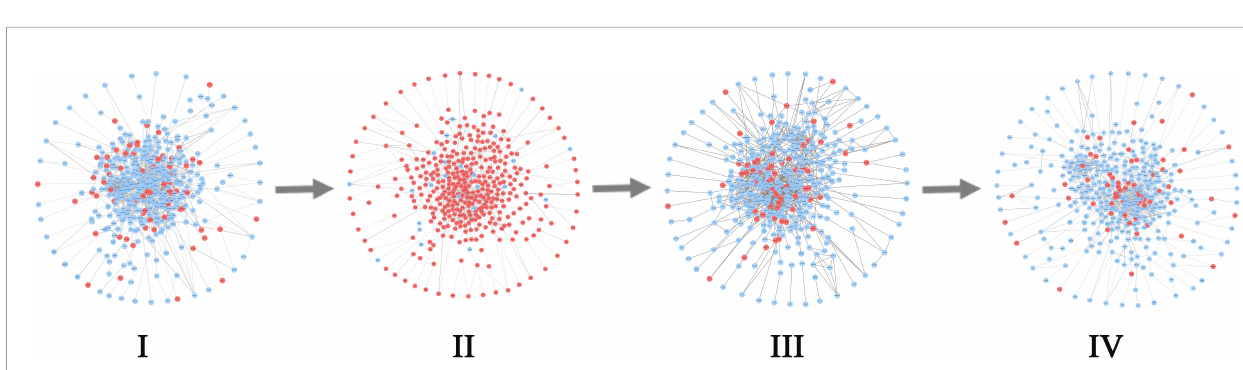
FIGURE 8 | The dynamic evolution of sJSD signal biomarkers for BLCA. There is a signi fi cant change in the internal structure of the sJSD signal biomarkers at stage II, in which red circles represent sJSD signal biomarker genes and blue circles represent non-sJSD signal biomarker genes.